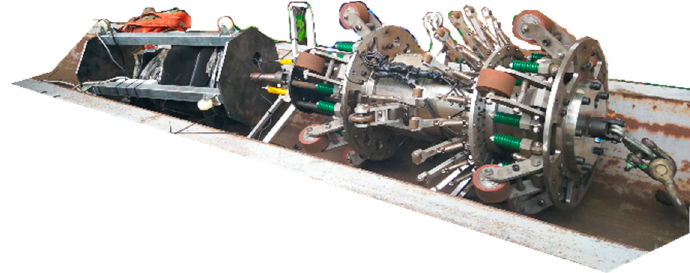
Figure 24. The working picture of the stress measuring instrument.